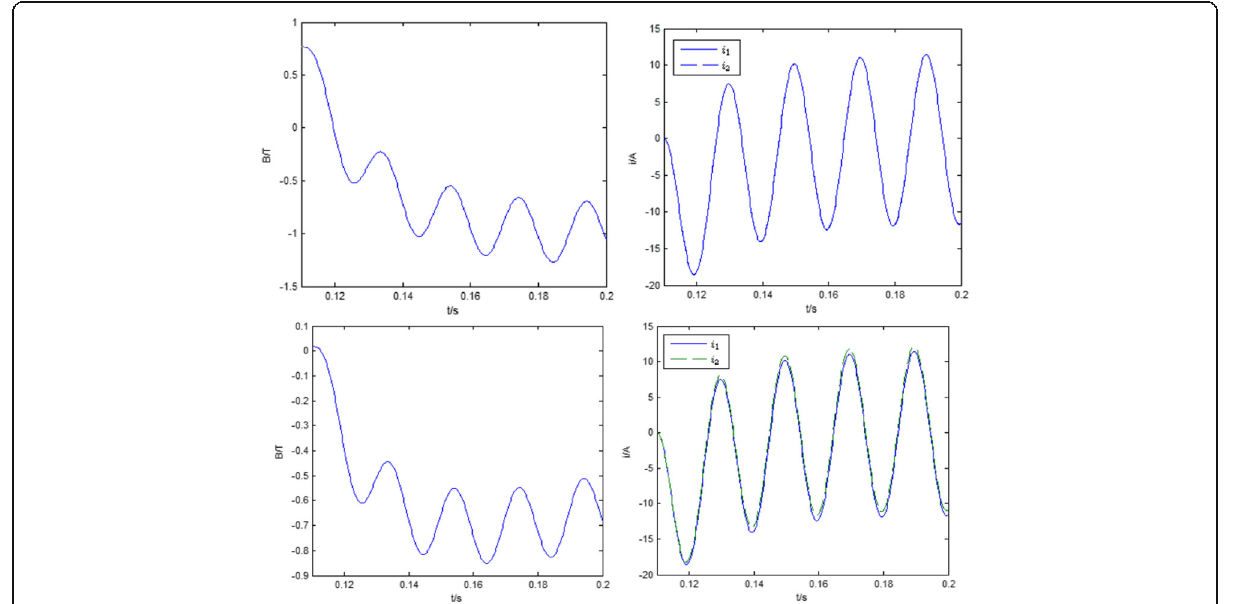
Fig. 15 50% remanence, magnetic flux generated at fault occurring time is negative